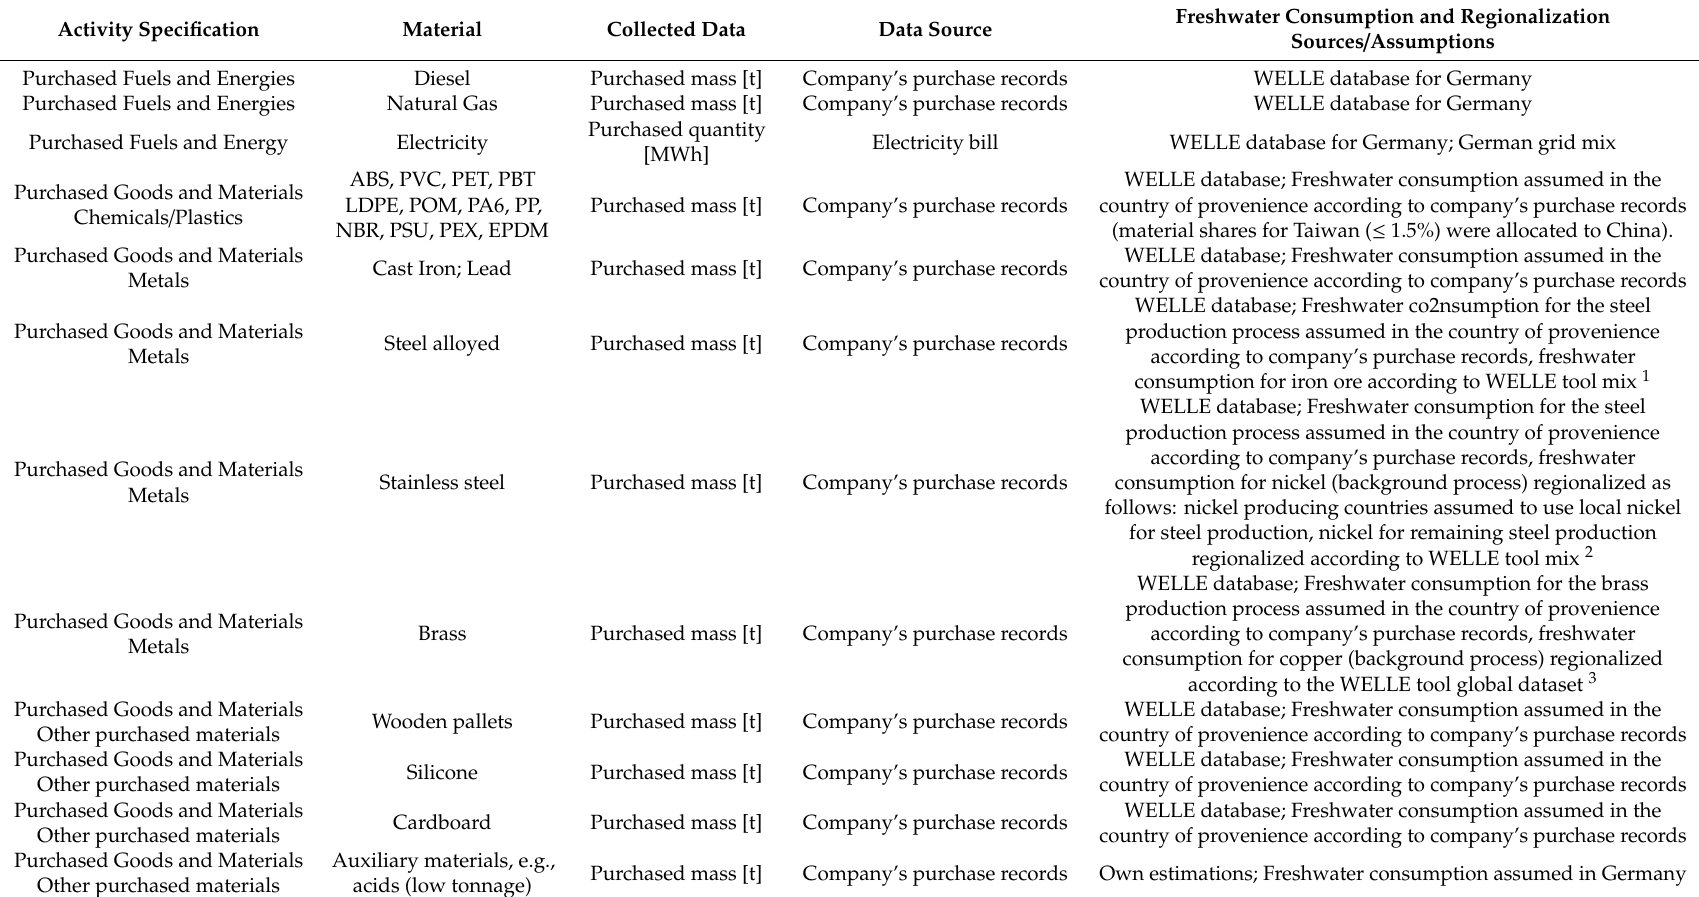
Table A1. Data sources and assumptions for indirect upstream activities, by material